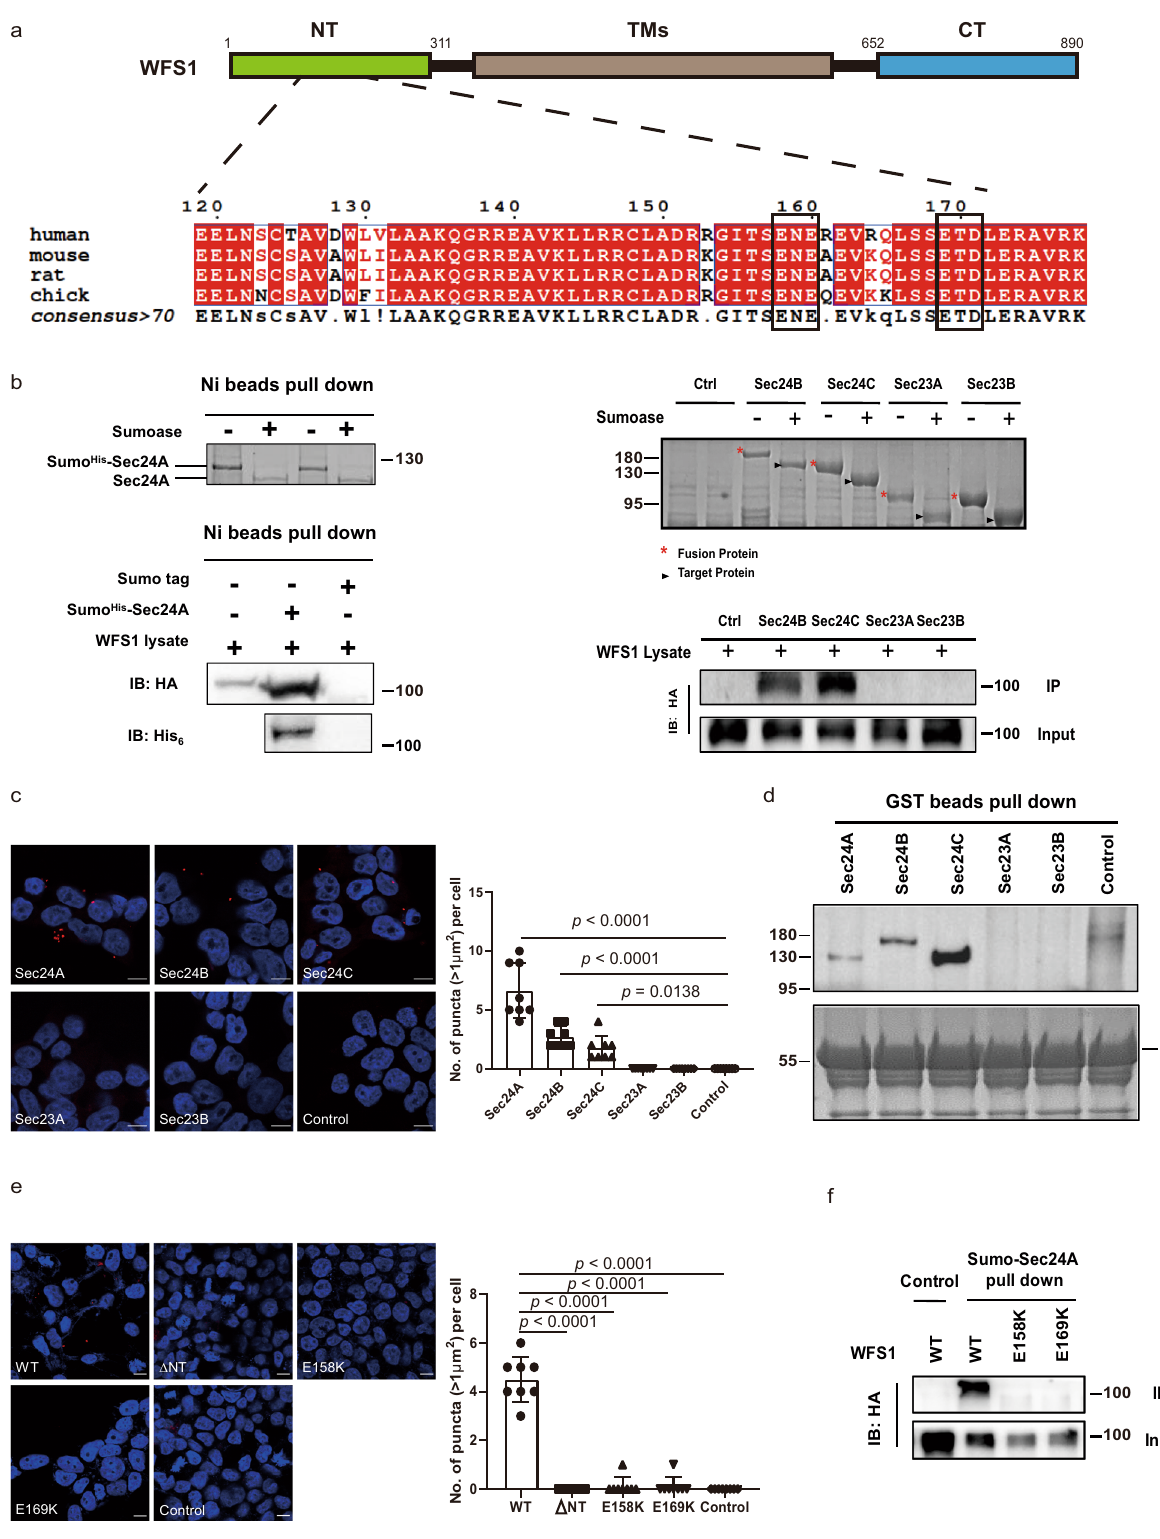
Furthermore, our results propose a potential molecular mechanism underlying the diabetes association with Wolfram syndrome induced by WFS1 pathogenic mutations. Previous studies have shown that WFS1 de fi ciency induces an increased ER stress response in pancreatic β -cells, eventually causing the progressive β -cell loss 13,16,17 . However, how the increased ER stress response was induced by WFS1 de fi ciency remains